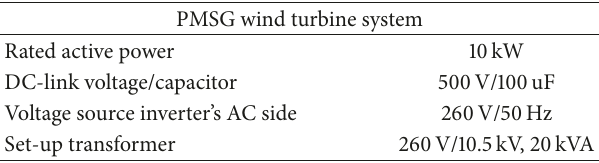
Table 4: Specifications of the PMSG wind turbine system.